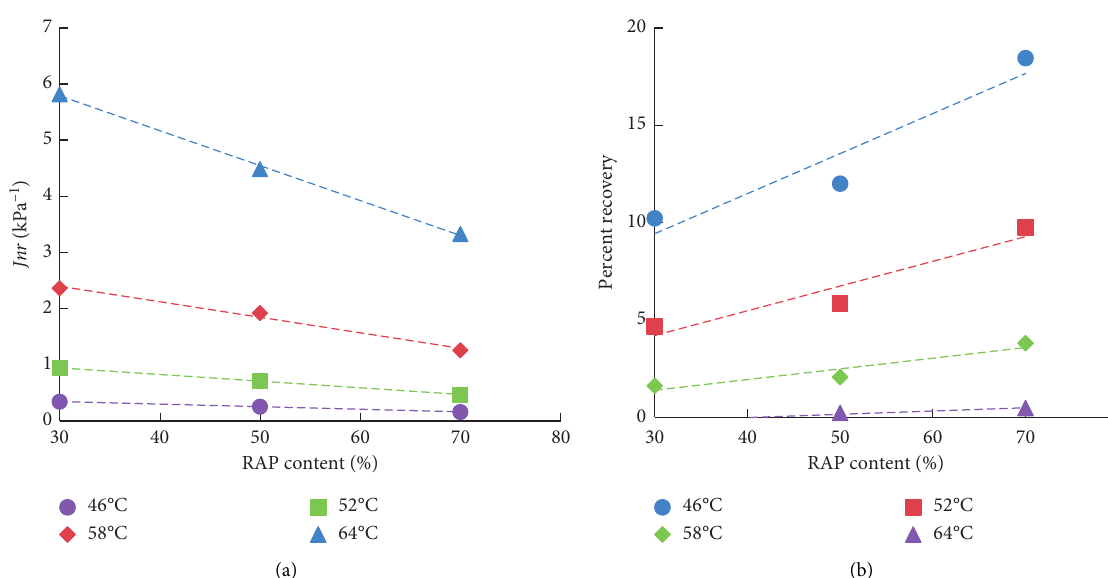
Figure 20: Relationship of aging asphalt content and MSCR parameters for RAP-R binders: (a) unrecoverable creep compliance and (b) creep percent recovery.